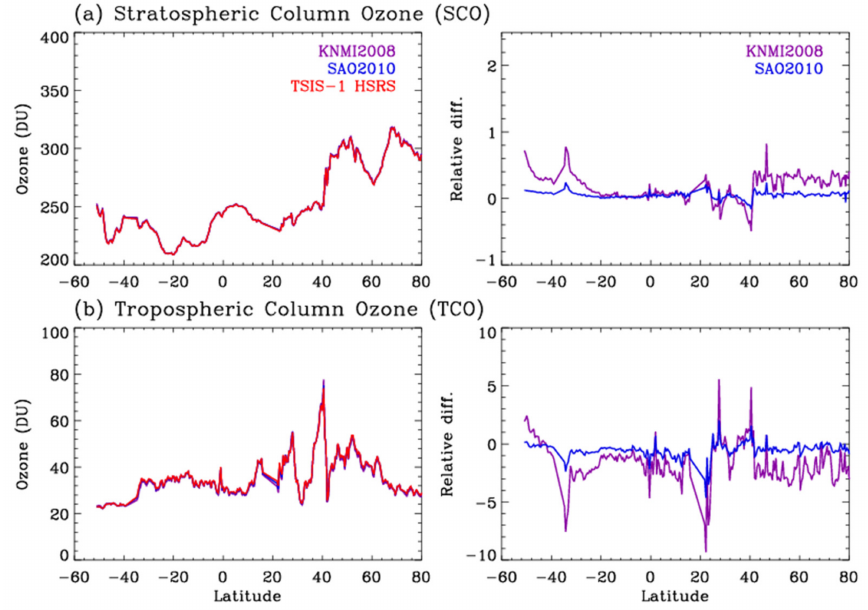
Figure 4. Same as Figure 3 but for vertically integrated ozone columns over the ( a ) stratosphere and ( b ) troposphere, respectively.